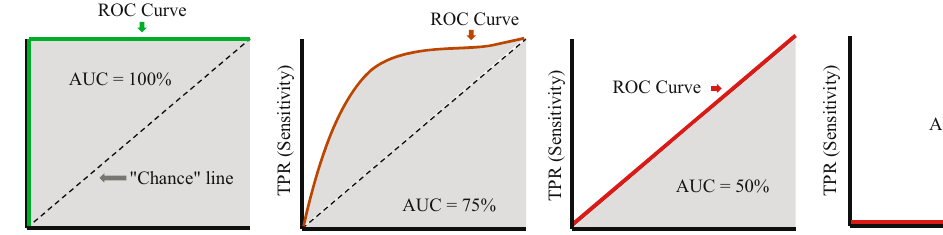
Figure 3: Described ROC curve and AUC [ 51 ]